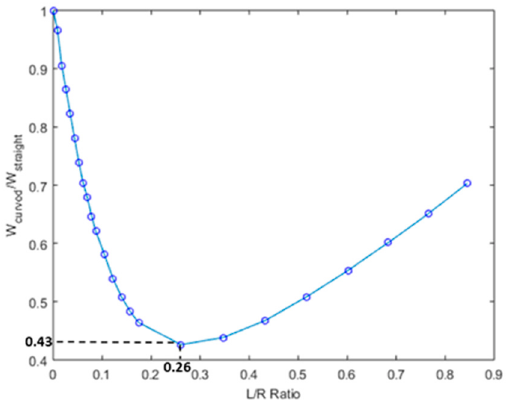
Figure 30. The buckling capacity ratio of curved members with different L/R ratios. For all selected perimeter beams with the same chord length (2 m), the buckling capacity of the beam varied with the beam L/R ratio (curvature). When the L/R ratio (curvature) of the beam was equal to 0, the selected beam was regarded as a perfectly straight beam. In this case, the load capacity of the selected beam was equal to the load capacity of a 2 m straight beam. With the increase in the beam’s curvature (L/R ratio), the load capacity of the beam gradually decreased. When the L/R ratio of the beam reached 0.26, the curved member exhibited the lowest buckling load capacity, which was only 43% of the buckling load of a perfectly straight